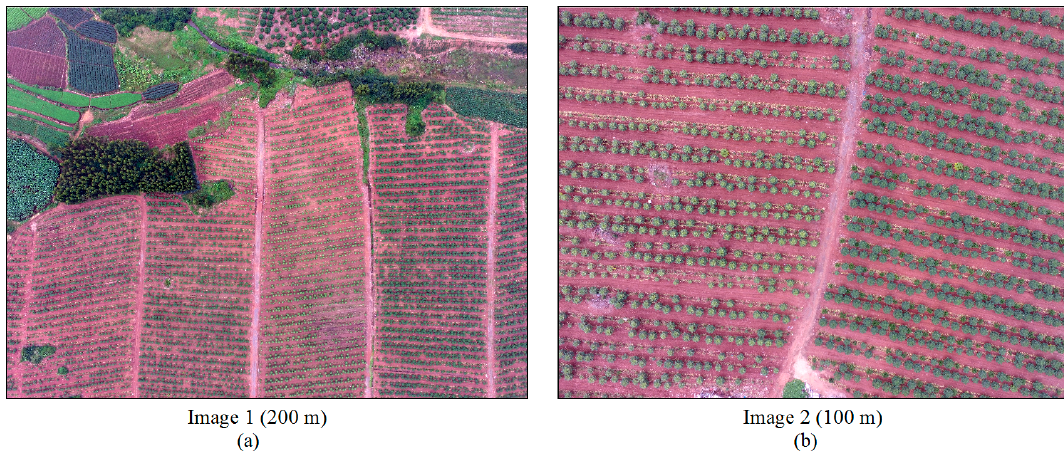
Figure 1. Two unmanned aerial vehicles (UAV) images used in this study. Image 1 and 2 were captured at the same orchard, but without spatial overlaps. ( a ) Image 1 (captured at an altitude of 200 m); and ( b ) Image 2 (captured at an altitude of 100 m). Table 1. Information of the two images.